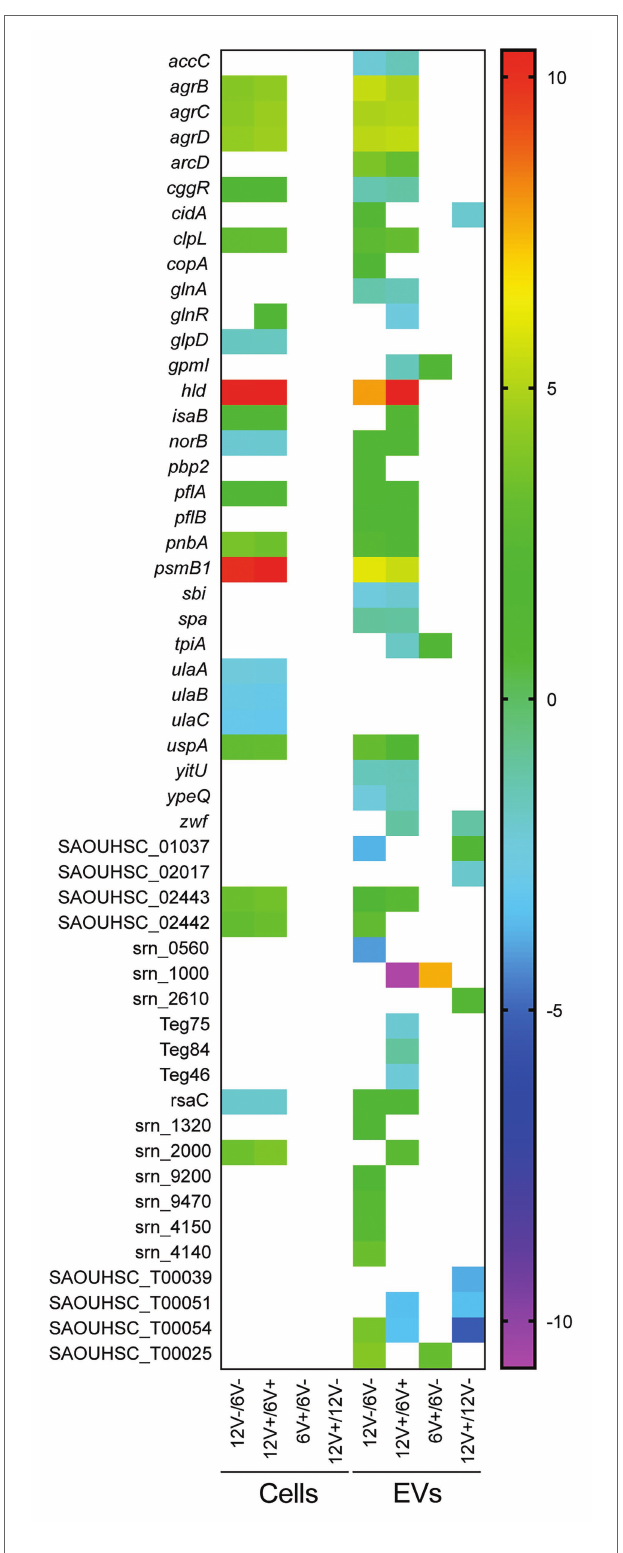
FIGURE 7 | Differential RNA abundance between the EV-producing cells and the EVs. Colored square shows different RNA abundance patterns between